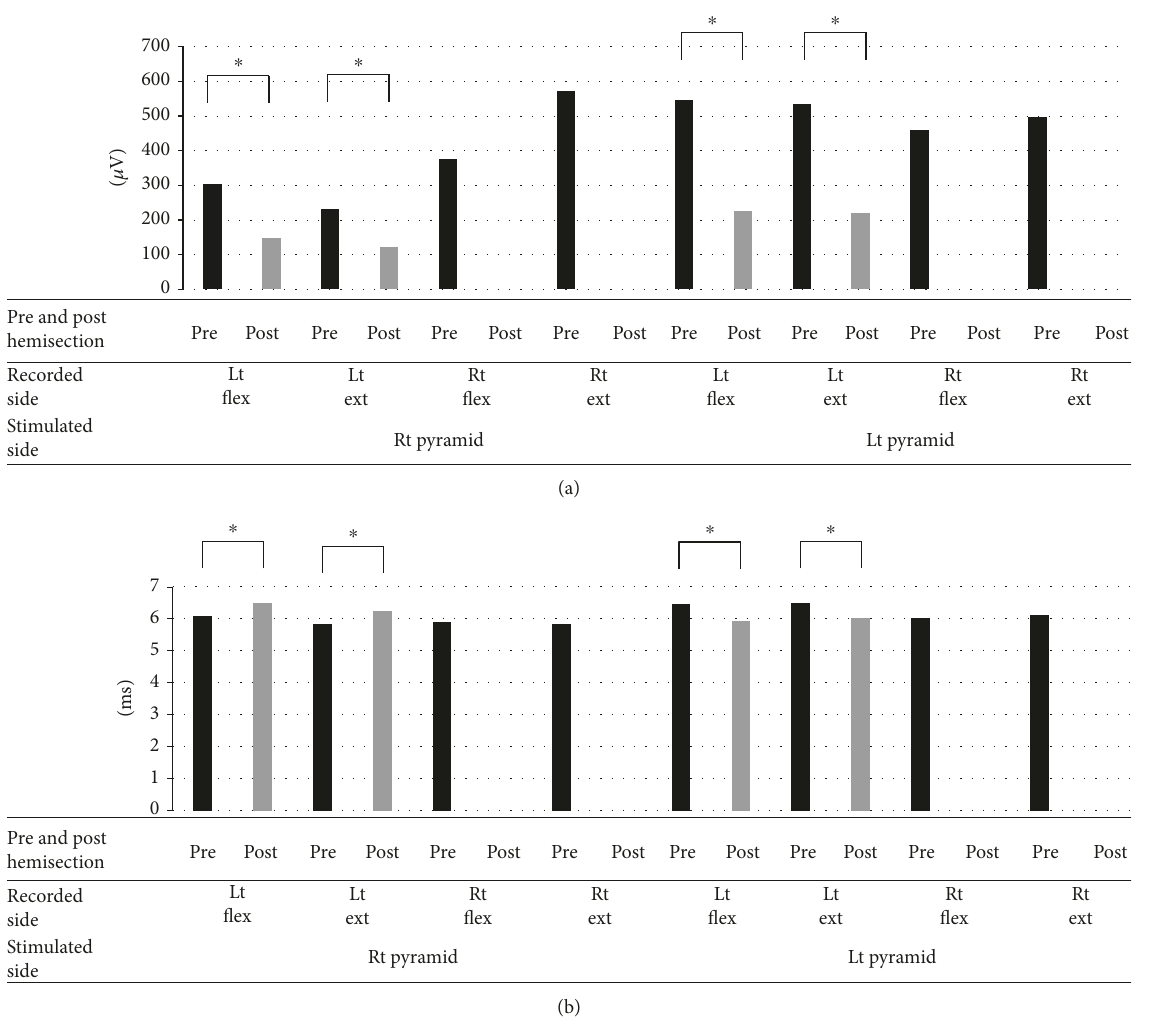
Figure 9: Amplitude (a) and latency (b) of CMAPs before and after the additional C2 hemisection performed on the C2 rat group. (a) In response to the stimulation of both the left and right pyramids, CMAPs of the right forelimb were lost after the additional right C2 hemisection, whereas the amplitude of CMAPs of the left forelimb was not lost although it decreased signi fi cantly ( ∗ p < 0 05 ). (b) Signi fi cant extension of the latency was found in the record of the left forelimb in response to the stimulation of the right pyramid, whereas a signi fi cant shortening of latency was found in the record of the left forelimb in response to the stimulation of the left pyramid ( ∗ p < 0 05 ). CMAPs: compound muscle action potentials; Rt: right; Lt: left; Flex: fl exor; Ext: